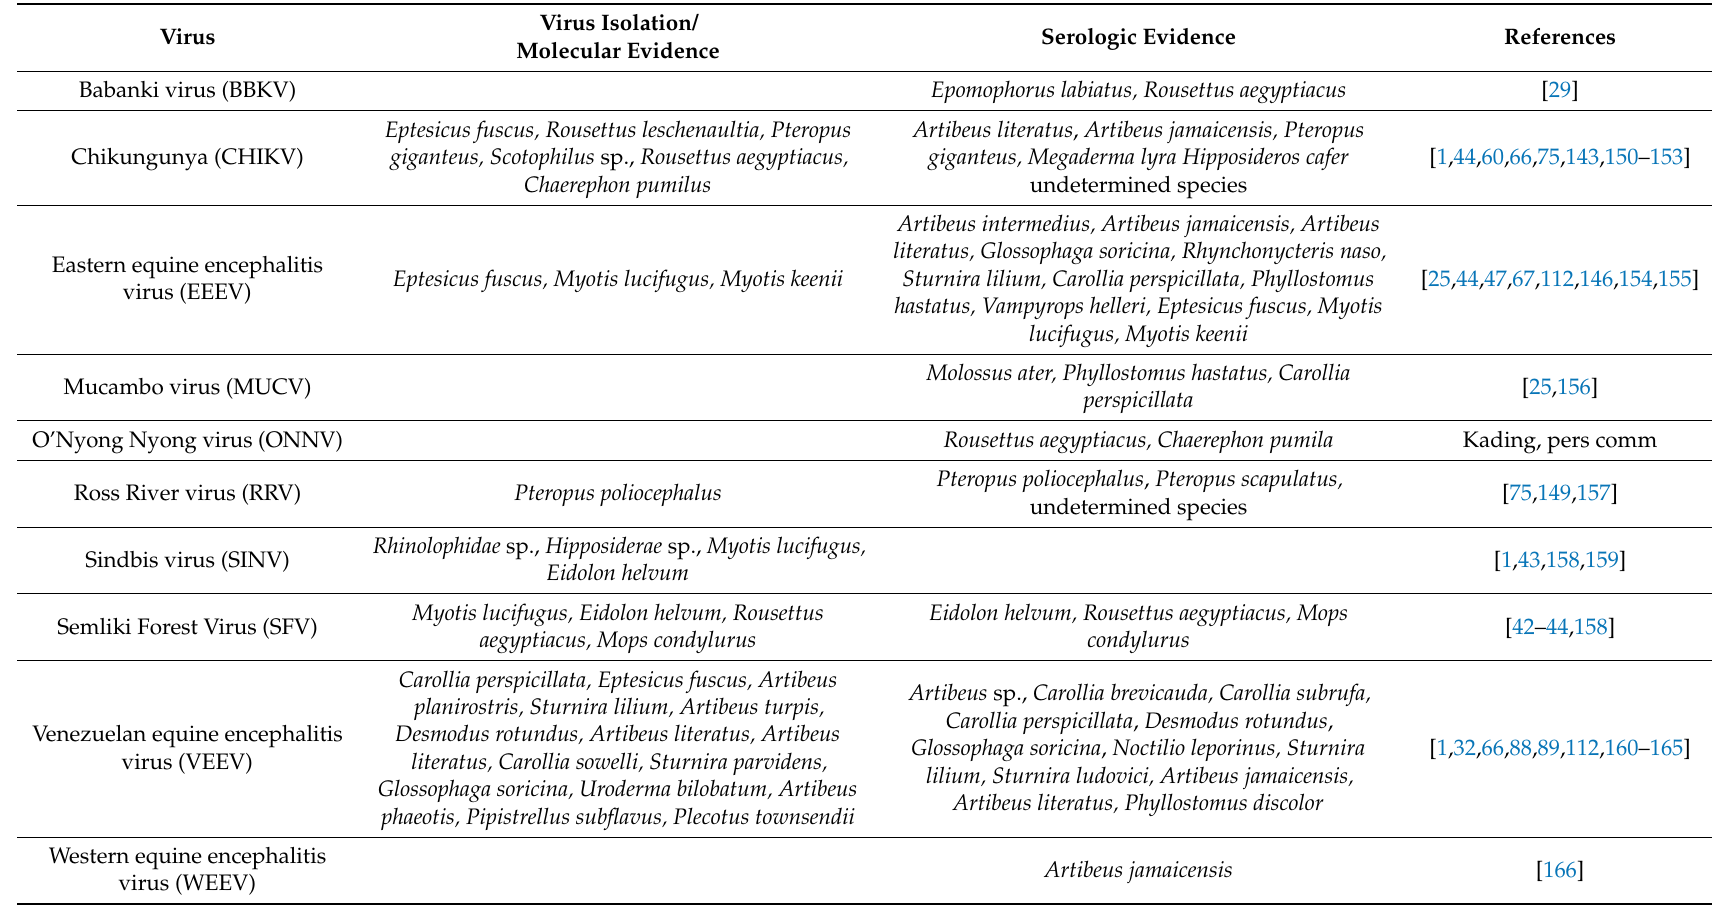
Table 4. Table describing species with published results describing virus isolation, molecular evidence, or seroconversion to species in genus Alphavirus (family